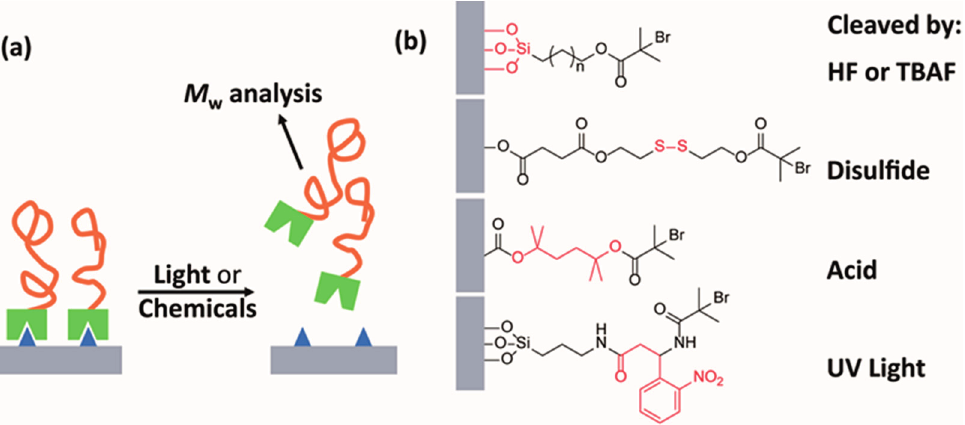
Figure 9. ( a ) Schematic depicting the cleavage of polymer brushes from the surface to obtain its molecular weight information (blue and green: cleavable functionality at the end of polymer brushes (orange)); and ( b ) Representative examples of cleavable functional groups (red-colored) by external stimuli